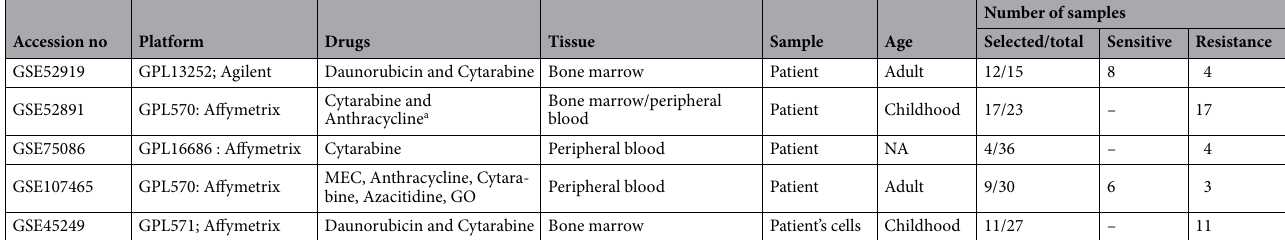
Table 1. Characteristics of the gene expression datasets included in the meta-analysis. MEC Mitoxantrone, Etoposide, Cytarabine, Go Gemtuzumab ozogamicin, NA not available. a Anthracycline: Daunorubicin, Idarubicin, Etoposide (VP16),